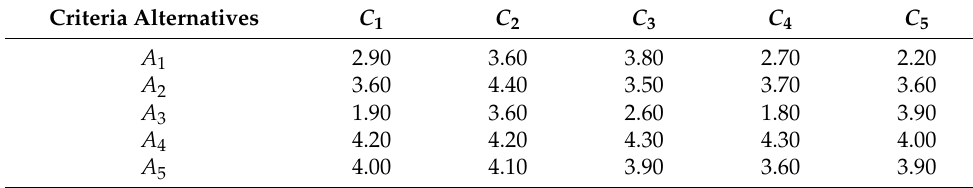
Table 7. Group decision-making matrix.